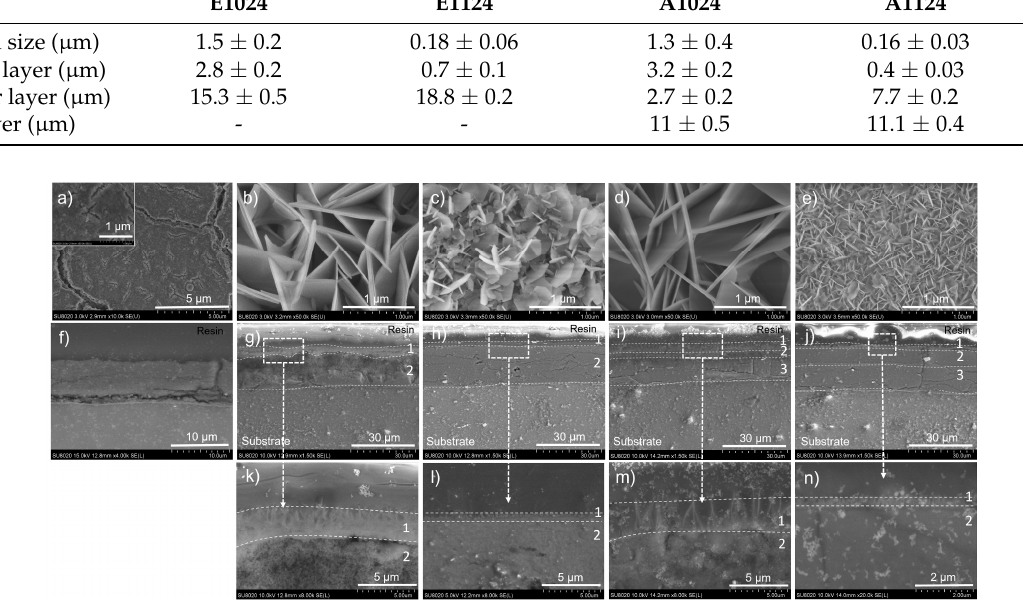
Figure 2. SEM images of surface: ( a ) anodized, ( b ) E1024, ( c ) E1124, ( d ) A1024, ( e ) A1124, cross- section: ( f ) anodized, ( g ) E1024, ( h ) E1124, ( i ) A1024, ( j ) A1124, and cross-section with higher magnification: ( k ) E1024, ( l ) E1124, ( m ) A1024, ( n ) A1124. ((1): porous outer layer, (2): compact inner layer, (3): anodic